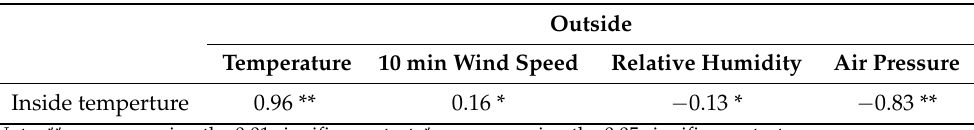
Table 1. The correlation coefficient between the inside temperature and the outside meteorological